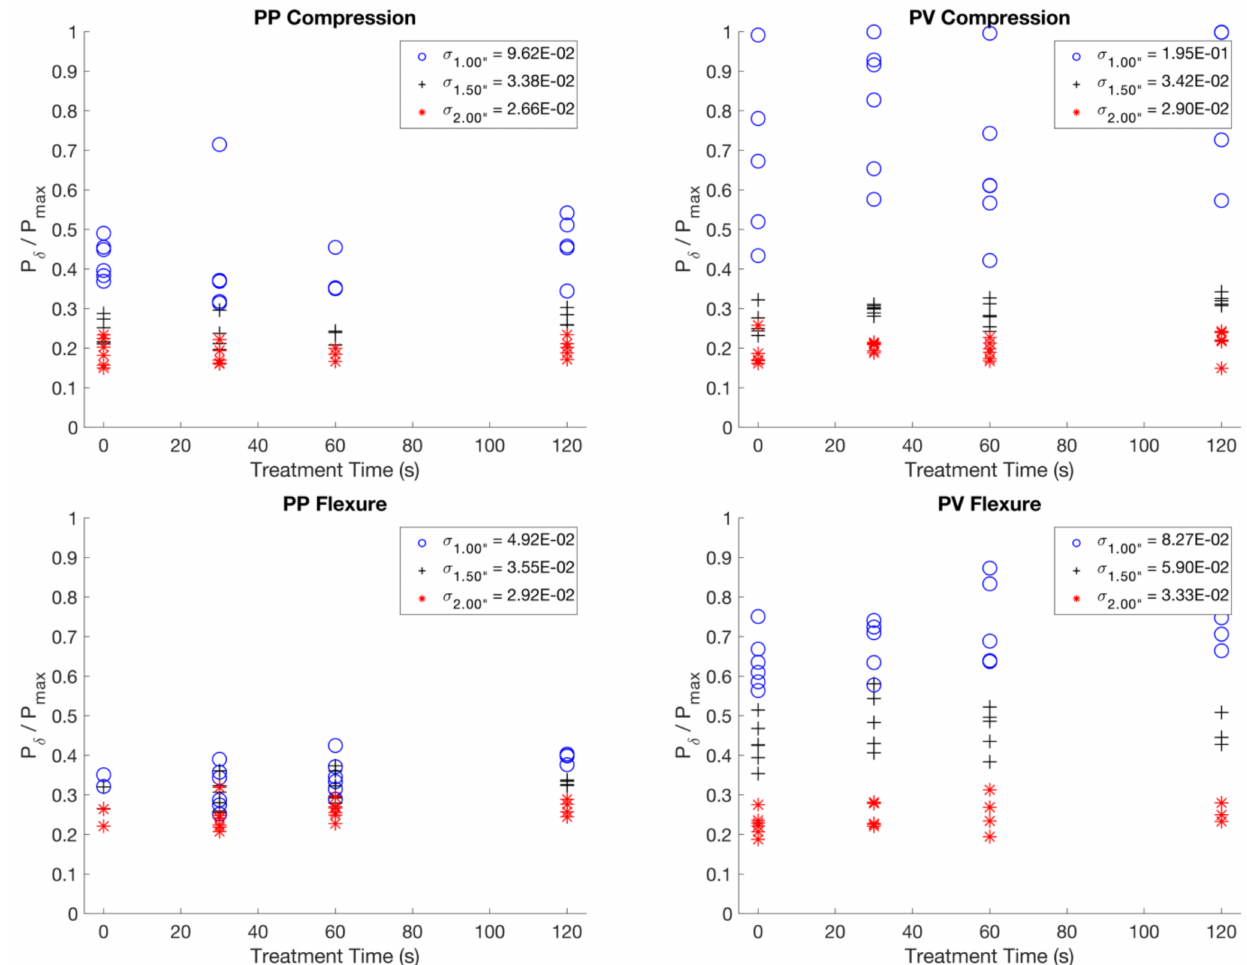
Figure 10. Scatter plots showing Treatment Time vs. P δ /P max . As displacement increased, the variability of P δ /P max decreased, regardless of treat- ment time. The decrease in standard deviation of P δ /P max ments was likely due to fibers taking on more stress during the softening branch of the loading curves for both compression and flexure. As the fibers engage with the mortar matrix, the capacities of mortar specimens at increasing displacements are controlled by the tensile properties of the fibers, as well as the pull-out characteristics of the fibers when the surrounding matrix cracks. Assuming a homogeneous fiber mix was achieved, the vari- ability of the load response post-peak was more consistent than in early stages of cracking, which is confirmed by the decreasing standard deviation with increasing displacement